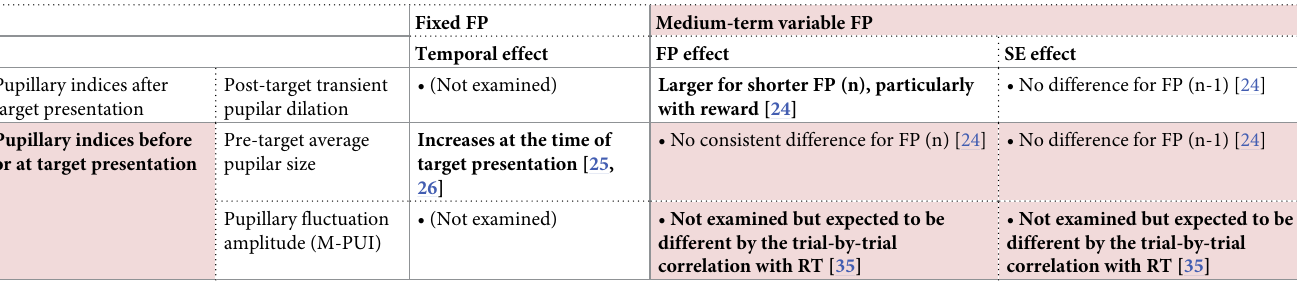
Table 1. Summary of previous pupillometry studies on temporal